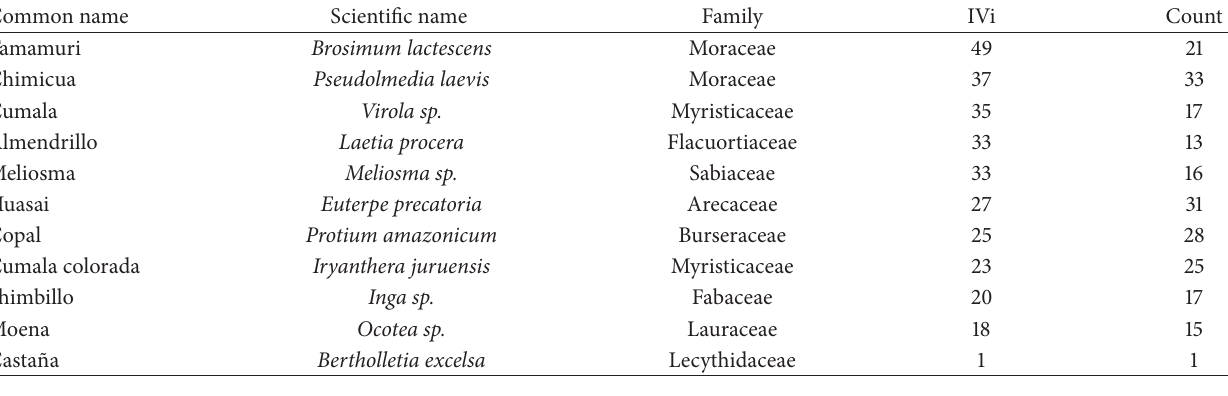
Table 1: The common name, scientific name, and family for the ten most frequent woody species in the UNAMAD experimental forest and Brazil nut (M. Usca, personal communication), ranked by Importance Value index (IVi) and calculated as the sum of relative density, relative frequency, and basal area. This data was collected in five 20 × 100 m transects, equaling 1ha.